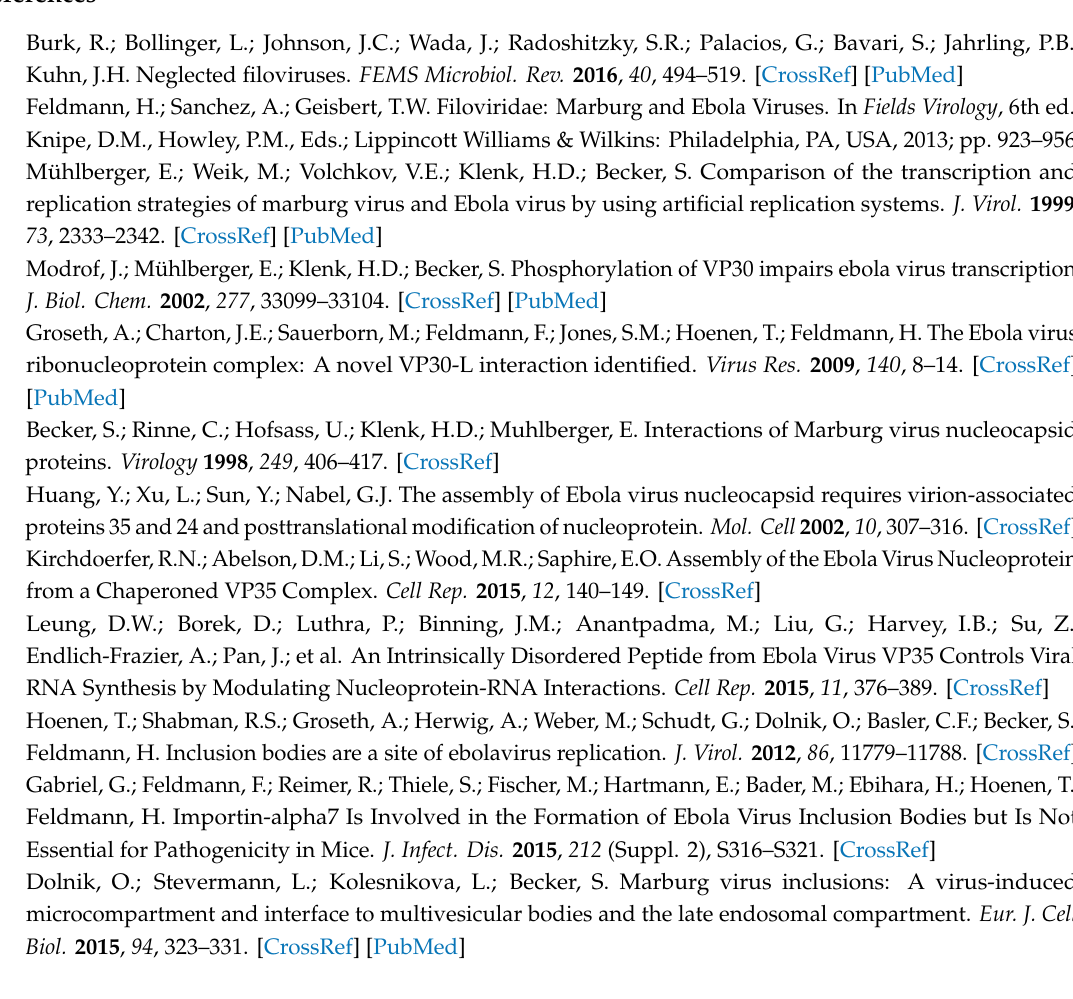
Figure S1: RNA dependence of the interaction between NXF1 and VP35; Figure S2: Influence of NXF1 overexpression on viral RNA synthesis and protein